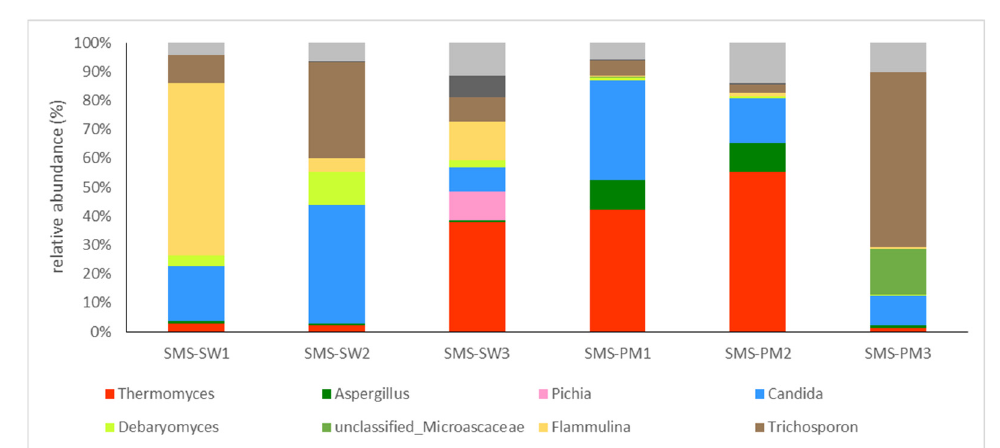
Basidiomycota (62.48%) and Ascomycota (35.11%) were the main fungi in all the sam- ples. The fungal compositions at the genus level are illustrated in Figure 3. Flammulina (16.45%), Candida (14.44%), Trichosporon (10.82%), and Thermomyces (9.05%) were the dom- inant genera in SMS-SW, whereas Thermomyces (20.95%), Trichosporon (14.48%), and Can- dida (12.73%) were the dominant genera in SMS-PW (Figure 3).